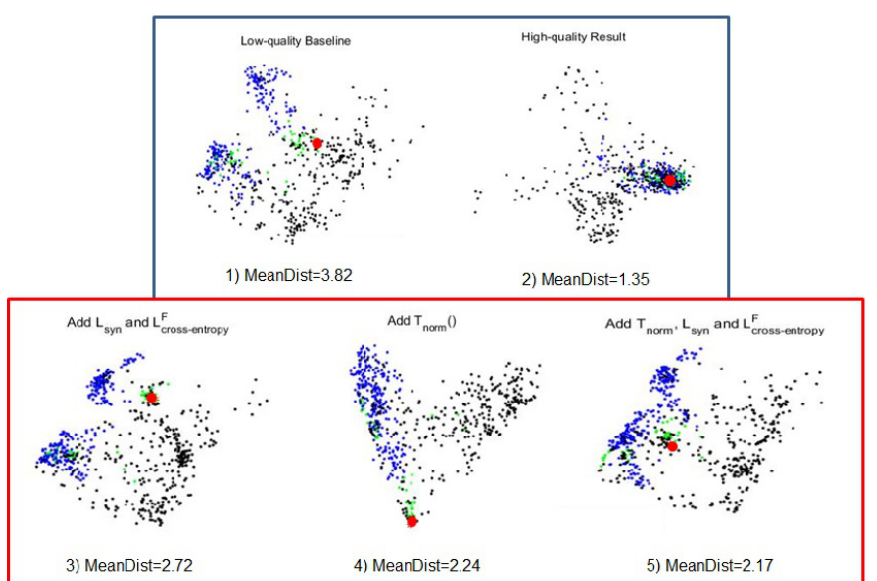
Figure 7. The distribution of the first two dimensions from PCA projections of the same person’s features that are extracted from the proposed methods, where the red point means sample of gallery, the green, blue, black points mean samples of NU, FE, PS in probe, and MeanDist means the Euclidean distance between all features of probe and the one of gallery. The figures in the blue box show the features extracted from low- and high-quality images without any strategies. The features extracted from low-quality images with one of methods on image-based, feature-based and fusion boosting strategies are shown in red